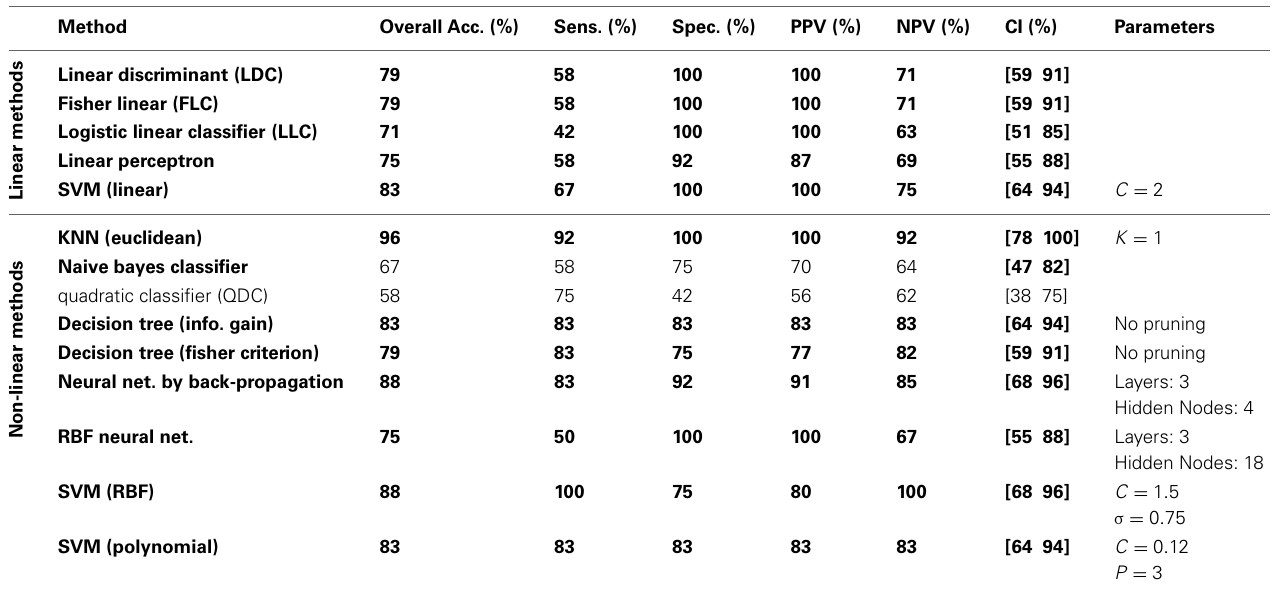
Table 3 | Testing classification results using reduced set of features (27 features).